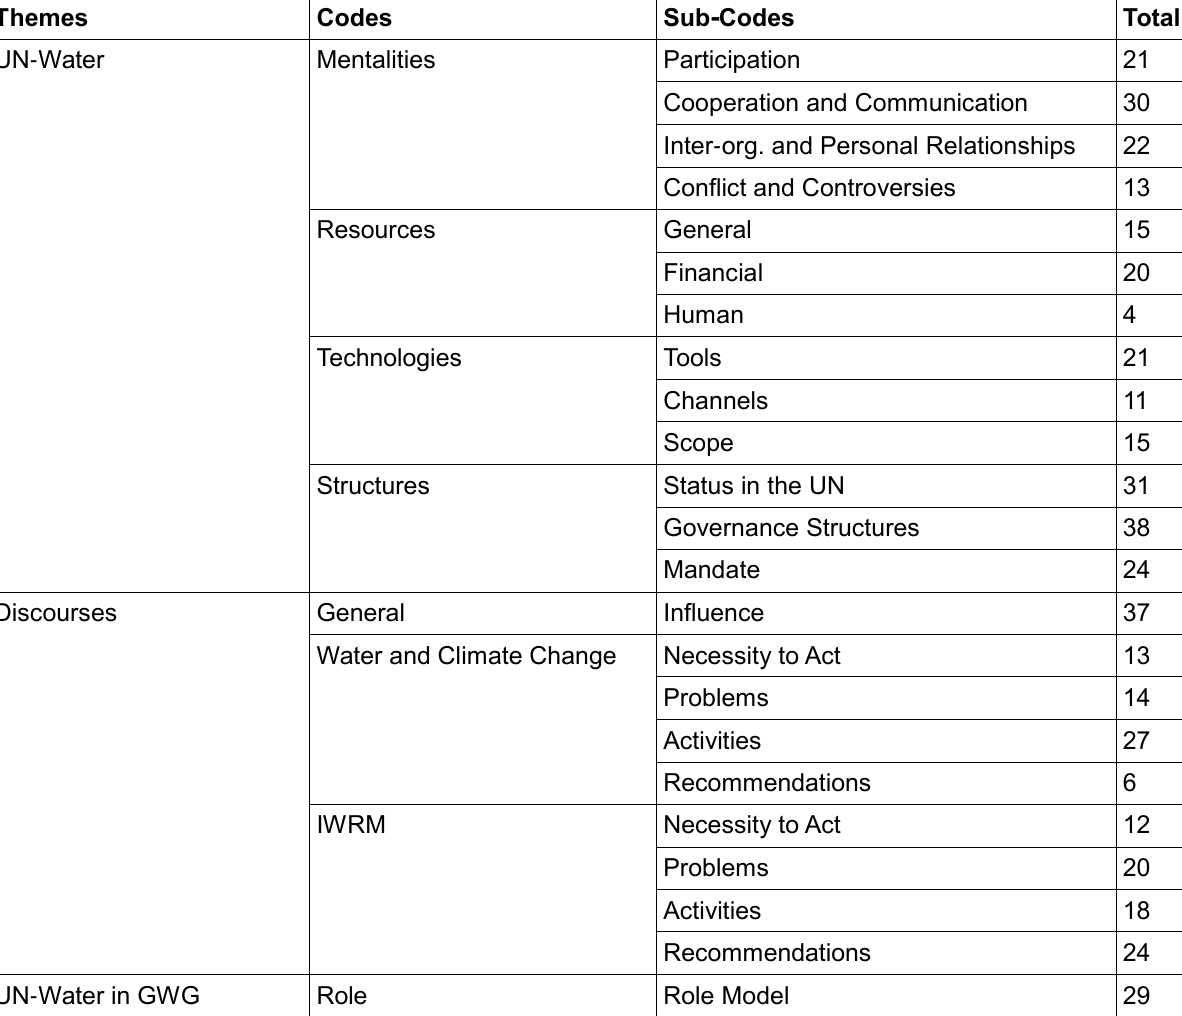
Table A1: Coding structure with themes, codes and sub - codes. The right column shows the number of text passages assigned to each sub -